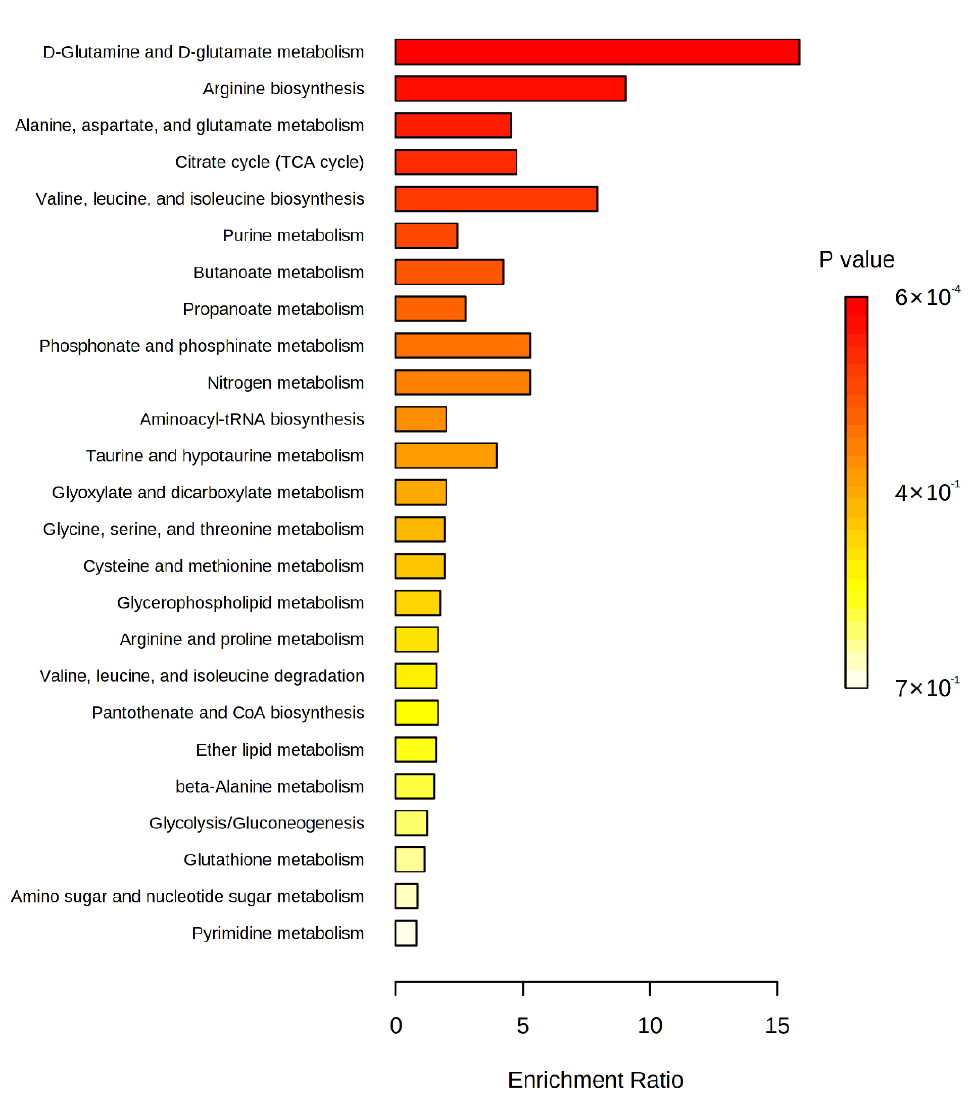
Figure 2. Enriched metabolite sets of significant metabolites between baseline and 18 months post- intervention on the basis of KEGG database.